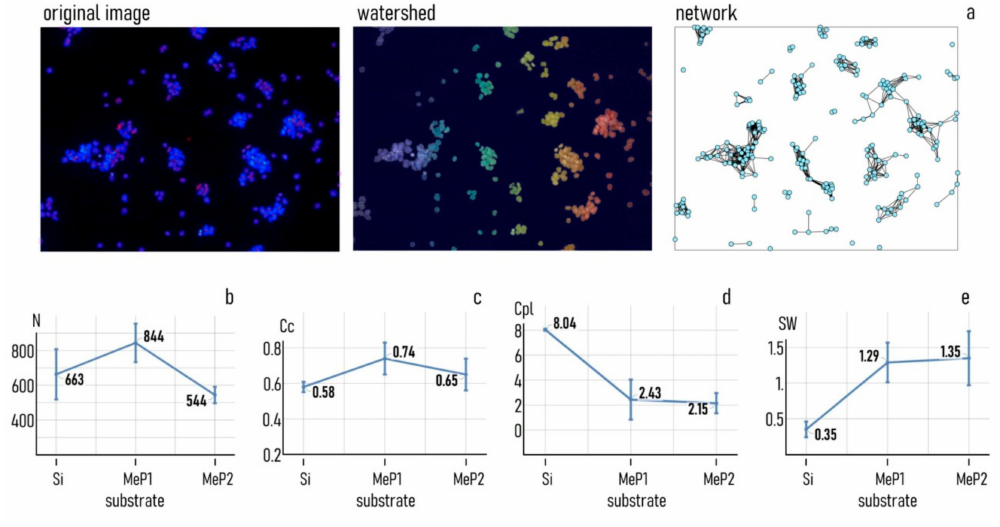
Figure 5. ( a ) Image analysis of fluorescence images: the original images were segmented with a watershed algorithm to identify individual cells, and cell nodes were then connected using the Waxman algorithm to obtain the equivalent graph for each sample. ( b ) Values of adhering cells, ( c ) clustering coe ffi cient, ( d ) characteristic path length, and ( e ) small-world-ness determined for the cultures of MCF-7 cell on MeP 1 , MeP 2 , and silicon surfaces 24 h from